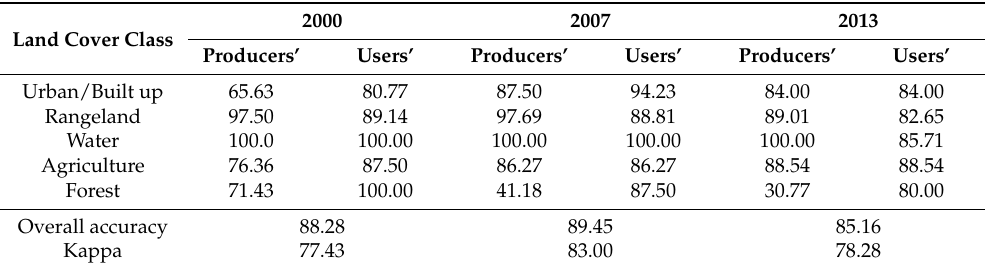
Figure 4. Land use and land cover dynamics in the Olifants Basin (2000–2013). Table 6. Summary of Landsat classification accuracies (%) for 2000, 2007 and 2013.